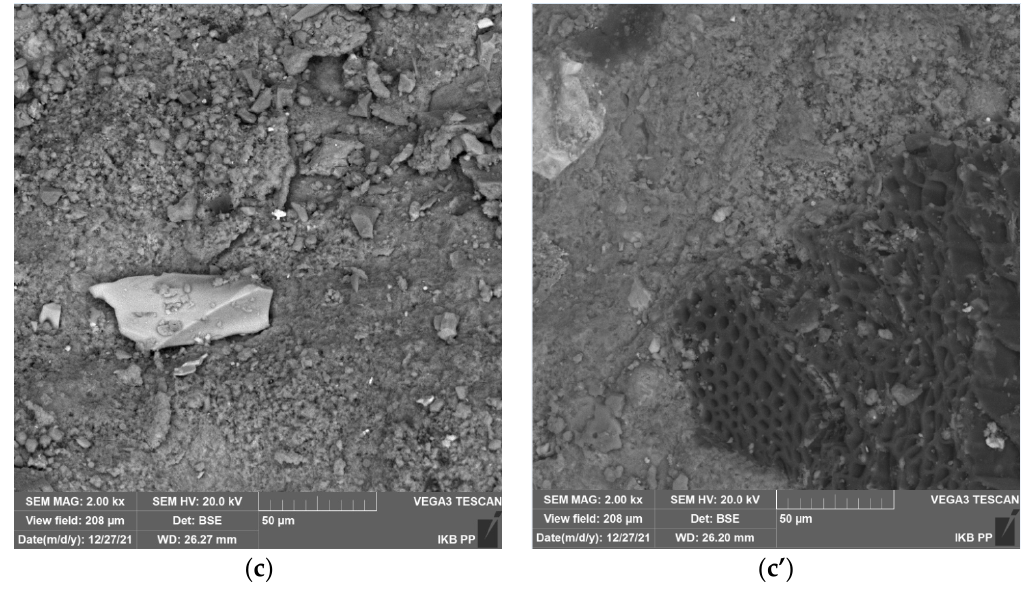
Figure 8. SEM images of cement mortars based on sand and sand with zeolite ( a , a’ ), cement mortars based on slag and slag with zeolite ( b , b’ ) and slag impurities ( c , c’